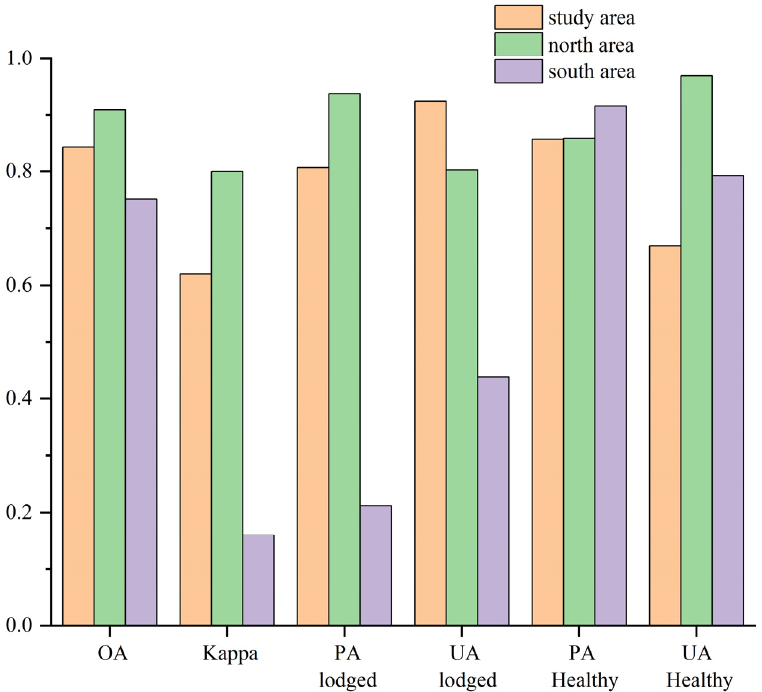
Figure 10. Accuracy evaluation results for different regions (the entire study area, north part, south part).